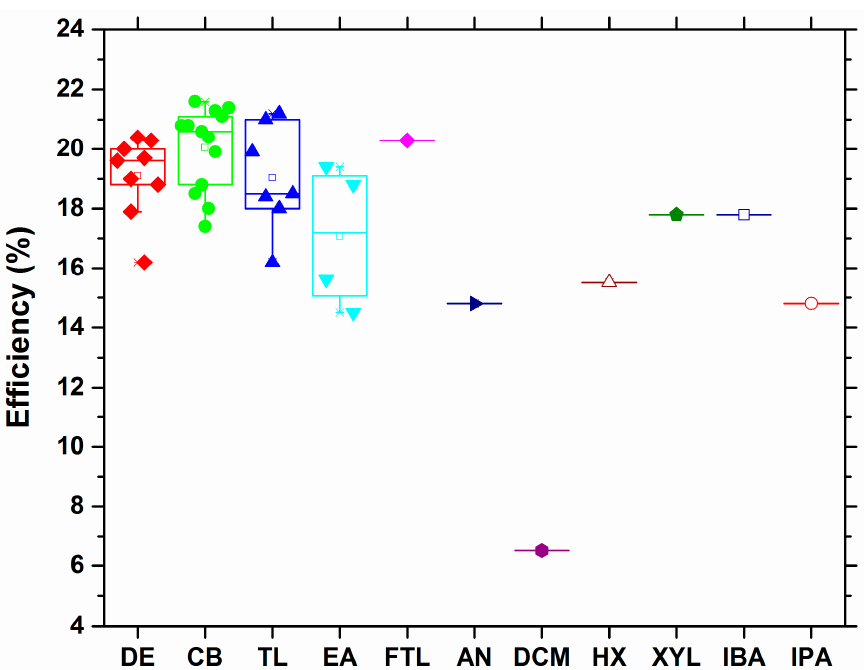
Figure 12. Overall photovoltaic efficiencies of various types of solar cells which use perovskite films fabricated by the application of different anti-solvents in the combined intermediate/anti-solvent crystallization method. Note that in the case of anisole (AN), a highly efficient solar cell based on a Pb/Sn mixed perovskite [73] was included in the analysis.